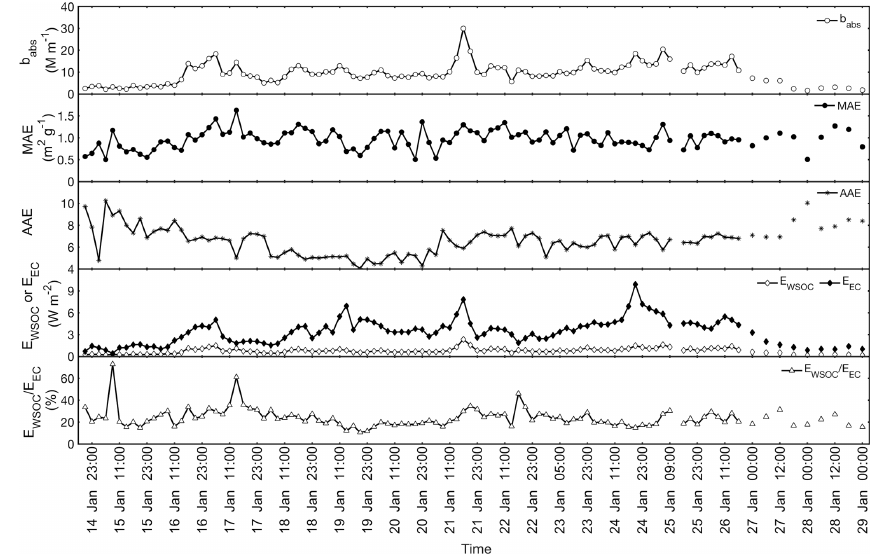
Figure 13. Time series of water-soluble BrC absorption coefficient ( b abs ), mass absorbance efficiency (MAE), absorption Ångström exponent (AAE), light absorption of WSOC ( E WSOC ) and EC ( E EC ) and the WSOC to EC light-absorption ratio ( E WSOC /E EC ) for PM 2 . 5 from 14 to 29 January 2015 in